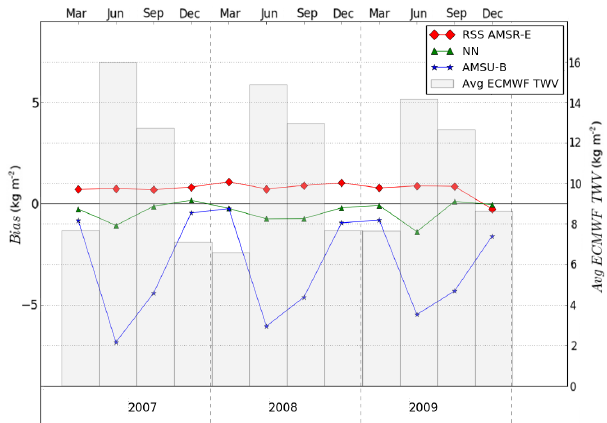
Figure 11. Bias for the new AMSU-B, AMSR-E RSS and AMSR-E neural network retrievals over open ocean versus ECMWF average TWV values. The curves represent the monthly averaged bias values for each of the three algorithms with the scale on the left. The ver- tical columns in the background represent the monthly mean TWV value from ECMWF data with the scale on the right.